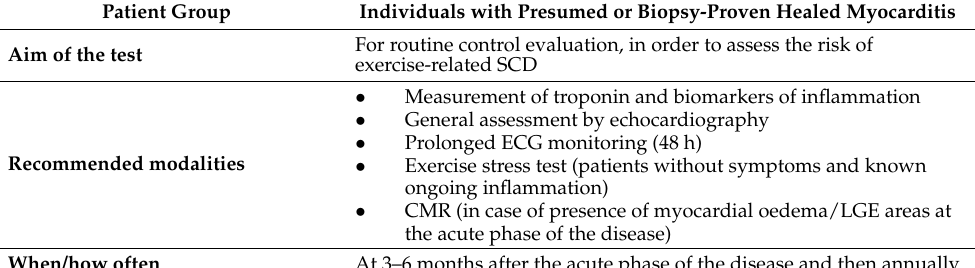
Table 6. Recommended tests for the follow-up assessment of patients with myocarditis (based on